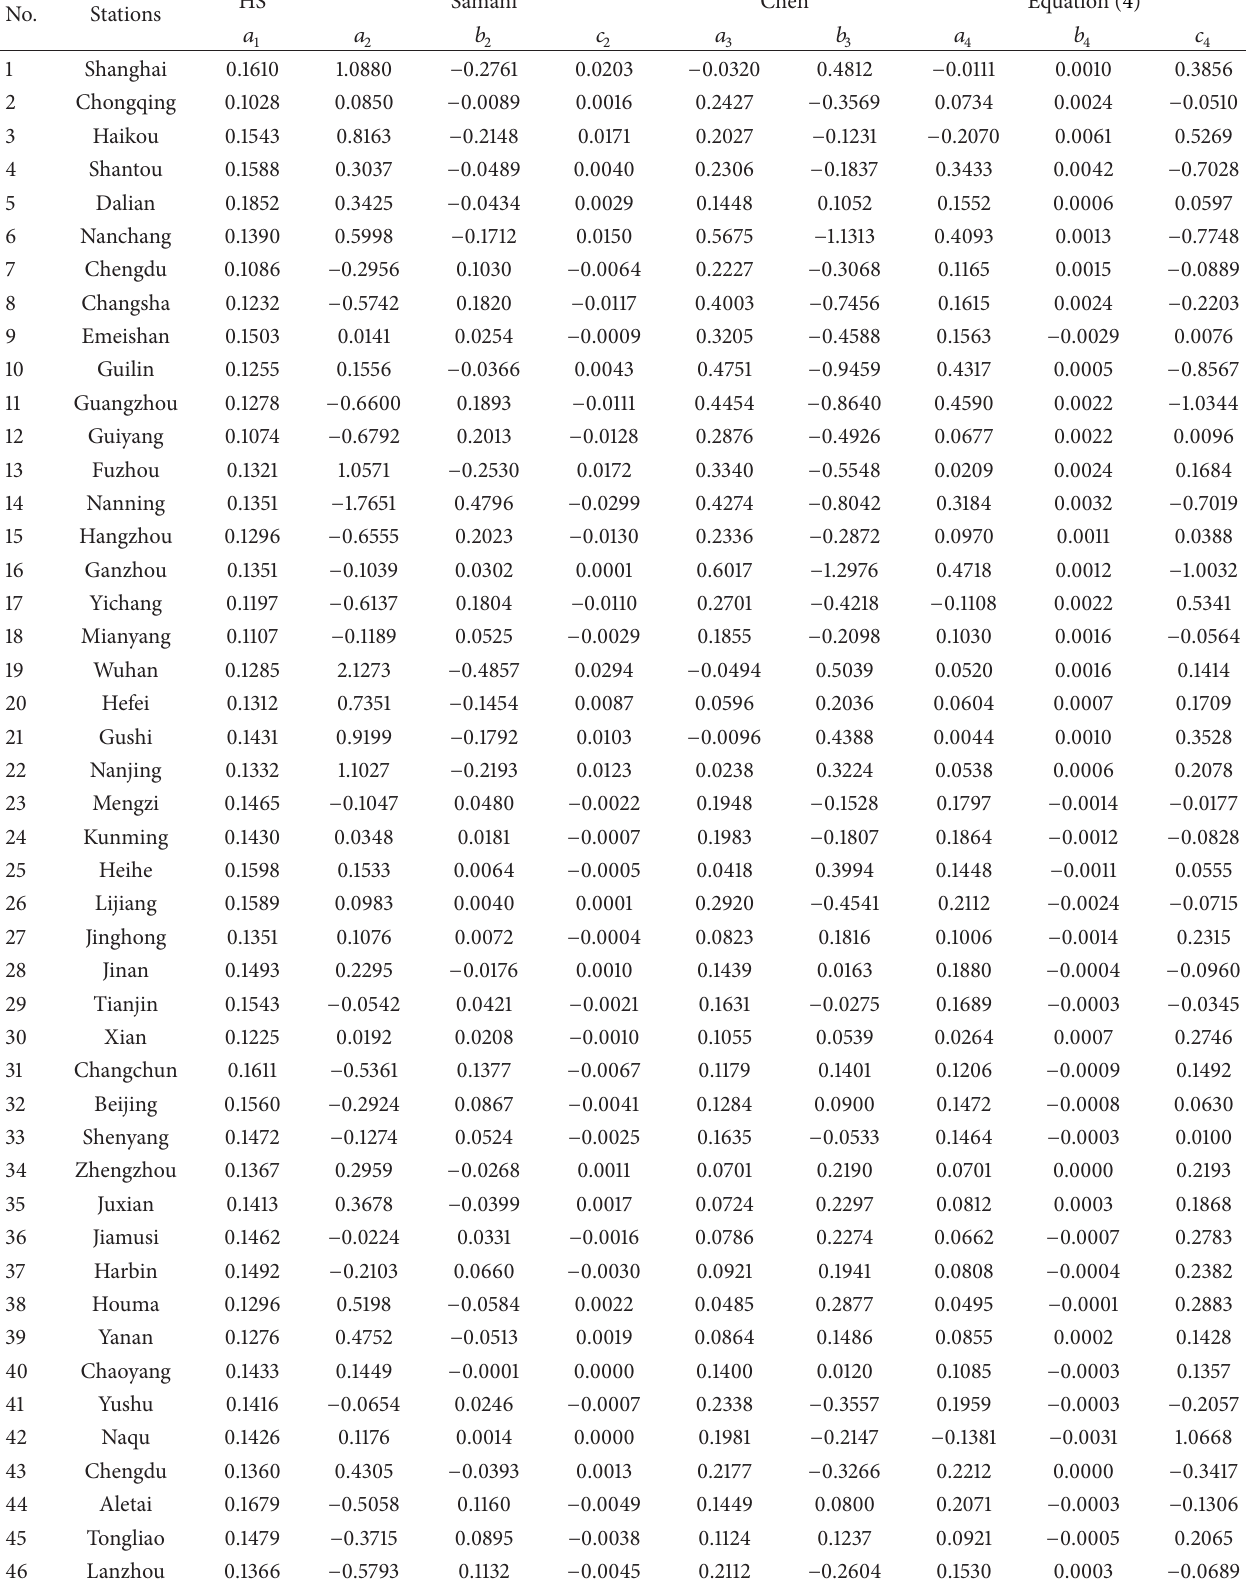
Table 2: Empirical coefficients of the four models at the 65 stations in